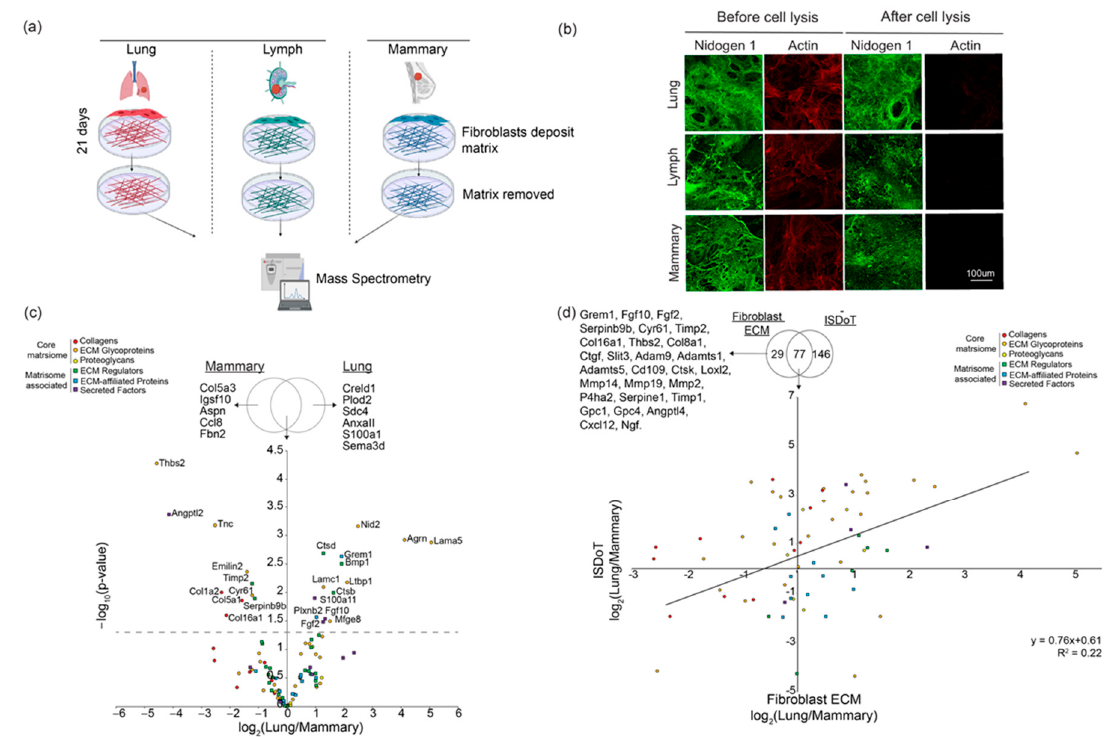
Figure 1. ( a ) Schematic showing the process of fibroblast-derived matrices and overview of experimental design. ( b ) Immunofluorescence imaging illustrating the lung, lymph, and mammary fibroblast matrices and deposited ma- trix, which is left intact post-lysis (visualised with Nidogen 1, green). Fibroblasts stained for actin (red). ( c ) Results of quantitative mass spectrometry, filtered for matrisome, of lung vs. mammary fibroblast-derived matrix (–log 10 p -value 1.3 indicates proteins significantly higher in each condition). Venn diagram displays which lung and mammary ECM proteins were detected in those conditions. ( d ) Comparison of ECM proteins between lung and mammary fibroblast-derived matrix, and lung and mammary decellularised organs using the ISDoT method. Simple linear regression of data shows R2 value of 0.22. Venn diagram shows that 77 ECM proteins were detected in both data sets, 29 ECM proteins were only detected in the FDMs, and 146 proteins in decellularised